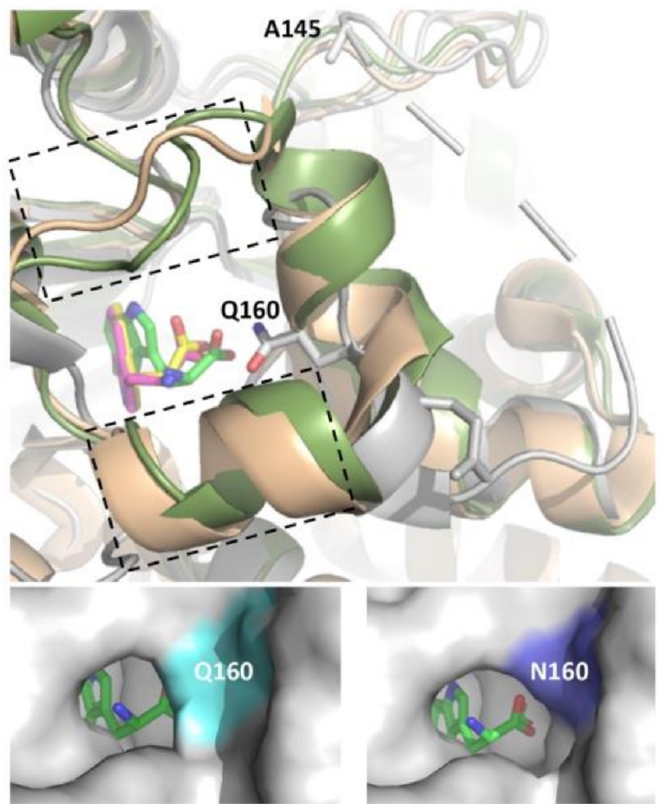
Figure 4. Top Panel: Structural overlay of PyrH (grey, bound tryptophan in green), PrnA (wheat, bound tryptophan in magenta) and RebH (green, bound tryptophan in yellow). Boxed region de‑ notes α ‑helical region (F458–N464 in RebH and F447–N453 in PrnA) and loop region (T343–F438 in RebH and N444–S448 in PrnA) that is absent in PyrH. The PyrH residues Q160 (mutated to N in Q160N variant) and A145 (deleted in PyrH–dASQV) are highlighted. Note that S146, Q147 and V148 also deleted in this mutant are not resolved in crystal structure. Bottom panels: Modeling of the PyrH Q160N mutation with bound tryptophan highlights cavitation of the active site region en‑ abling access to larger peptidic substrates. Images generated based on structures 2WEU [26] (PyrH),